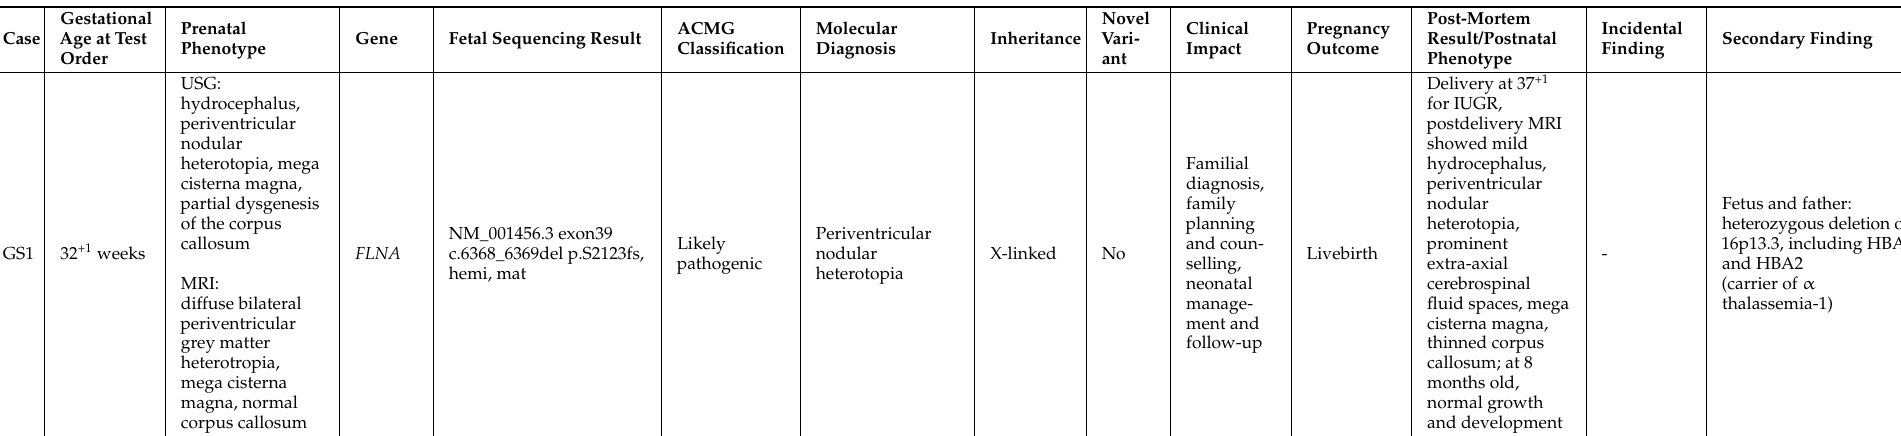
Table 3. Results of whole genome